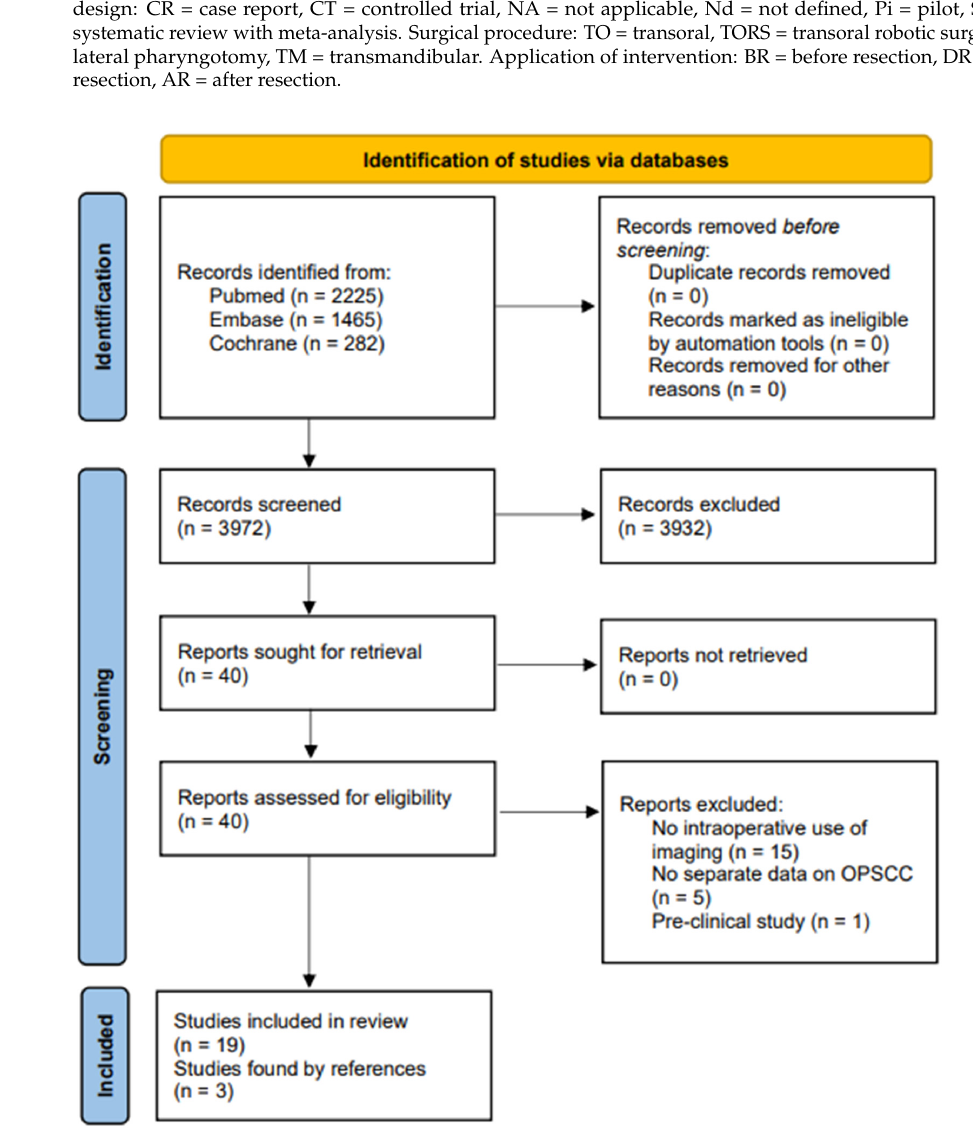
Figure 1. Study selection flow chart. Table 1. Included articles.